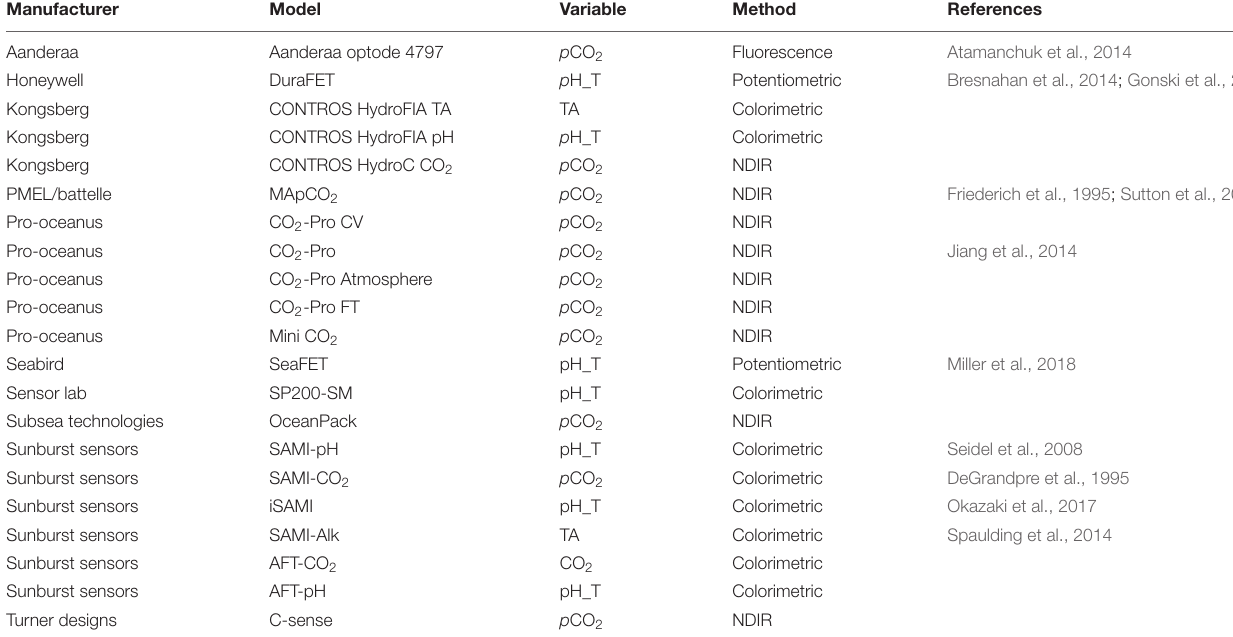
TABLE 1 | Examples of commercially available marine CO 2 system analyzers and